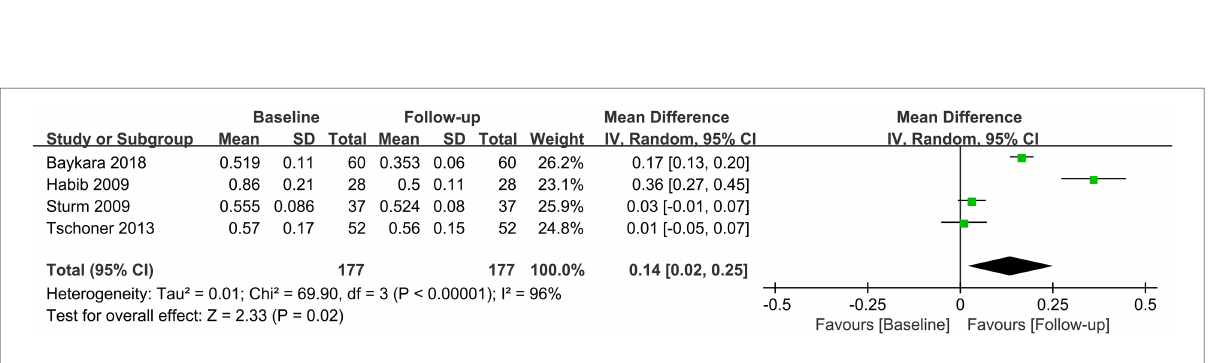
FIGURE 4 Forest plot of meta-analysis of CIMT more than 18 months after bariatric